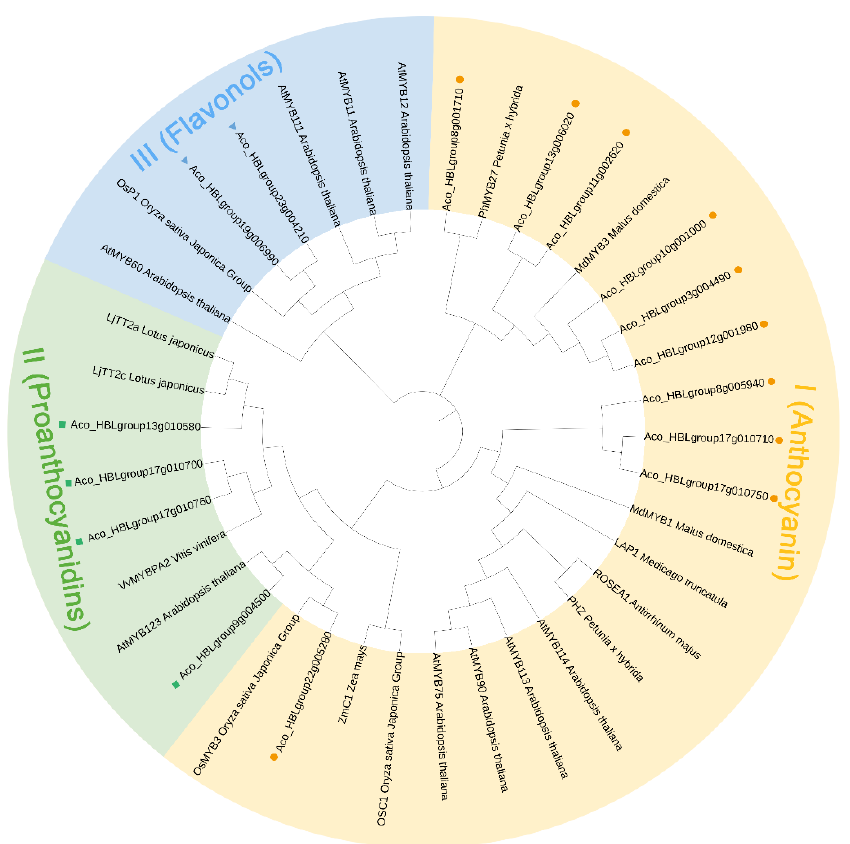
Figure 6. Phylogenetic analysis of the candidate AbR2R3-MYBs related to anthocyanin biosynthesis, flavonoids biosynthesis, and proanthocyanidin biosynthesis. The circles, squares, and triangles represent AbR2R3-MYBs in each